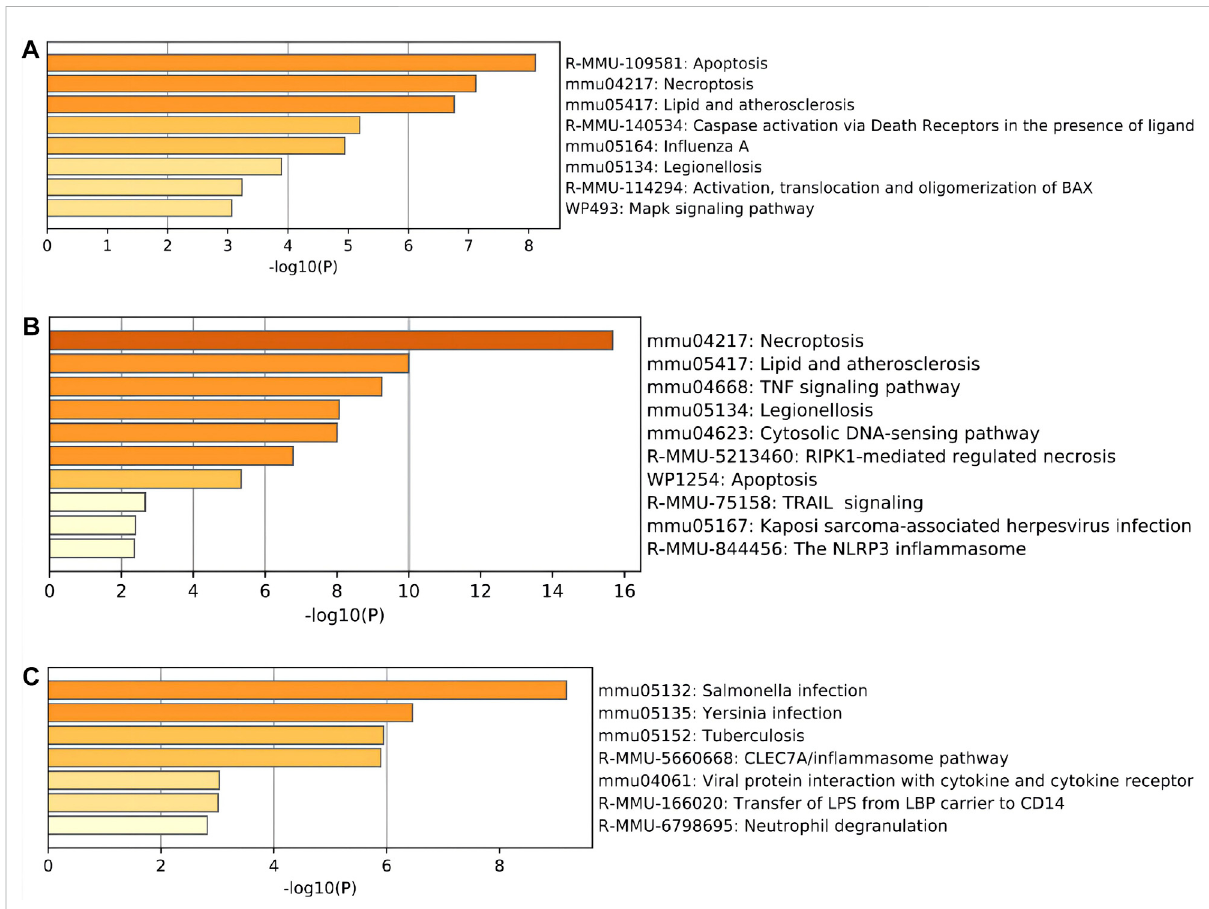
FIGURE 4 Pathway enrichment analysis of these differentially expressed programmedcell death (PCD)-related genes. (A) Signi fi cantly enriched pathways of differentially expressed apoptosis-related genes (DEARGs). (B) Signi fi cantly enriched pathways of differentially expressed necroptosis-related genes (DENRGs). (C) Signi fi cantly enriched pathways of differentially expressed pyroptosis-related genes